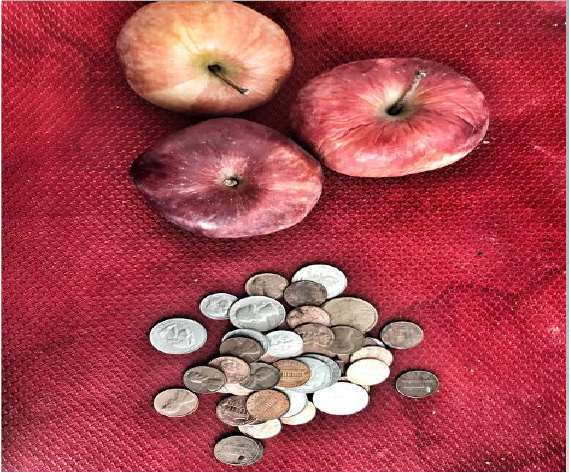
Figure 6. Food insecurity.